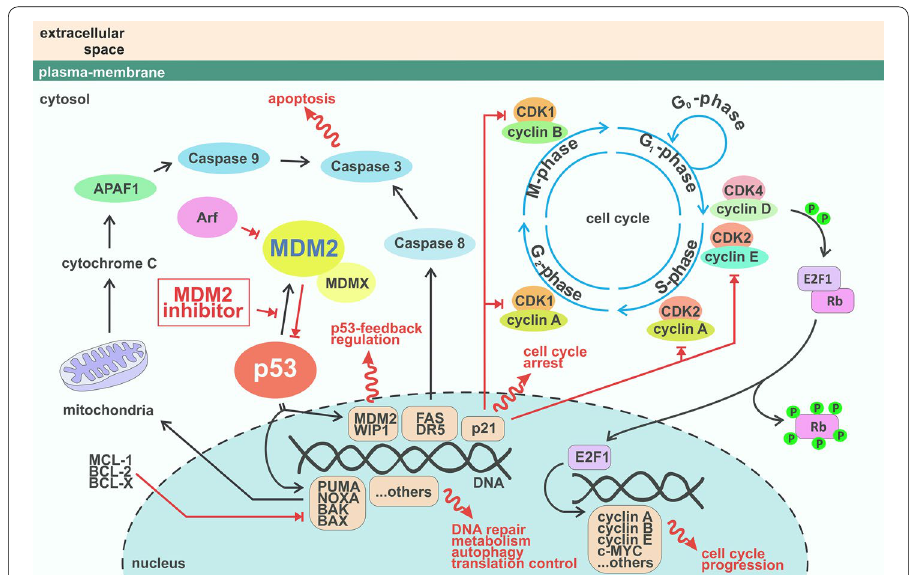
Fig. 4 Crosstalk of cell cycle and p53 pathway. p53 activity is under the direct control of MDM2. When the MDM2‑p53 interaction is interrupted via stress signals or specific MDM2 inhibitors, p53 accumulates and activates its direct transcriptional targets, resulting in protein production: p21 involved in cell cycle arrest; PUMA, NOXA, BAX, BAK involved in the intrinsic apoptotic pathway; DR4 and FAS involved in the extrinsic apoptotic pathway; MDM2, WIP1 involved in p53 feedback regulation and many others participating in DNA repair, cell metabolism, autophagy, and translational control. Cell cycle progression is controlled by p53 activity mainly via p21 protein, which associates with and inactivates CDK/cyclin complexes and blocks cell cycle progression. CDK4/6 with cyclin D/E controls the activity of RB and E2F1. When RB is hyperphosphorylated, it is released from binding to E2F1, and E2F1 then activates its transcriptional program, leading to cell cycle